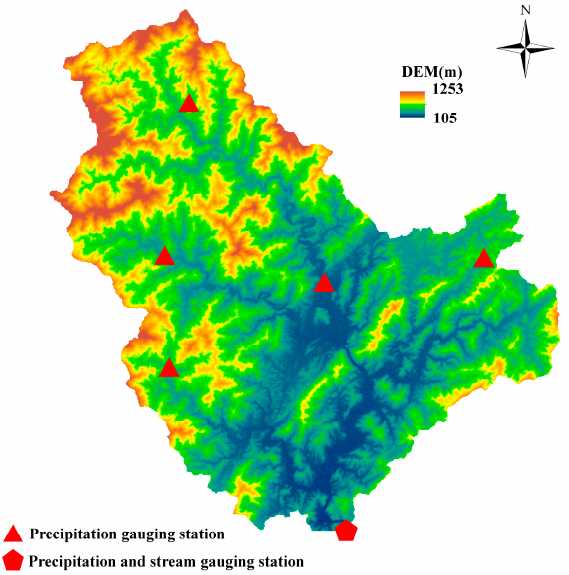
Figure 3. Map of the Misai basin